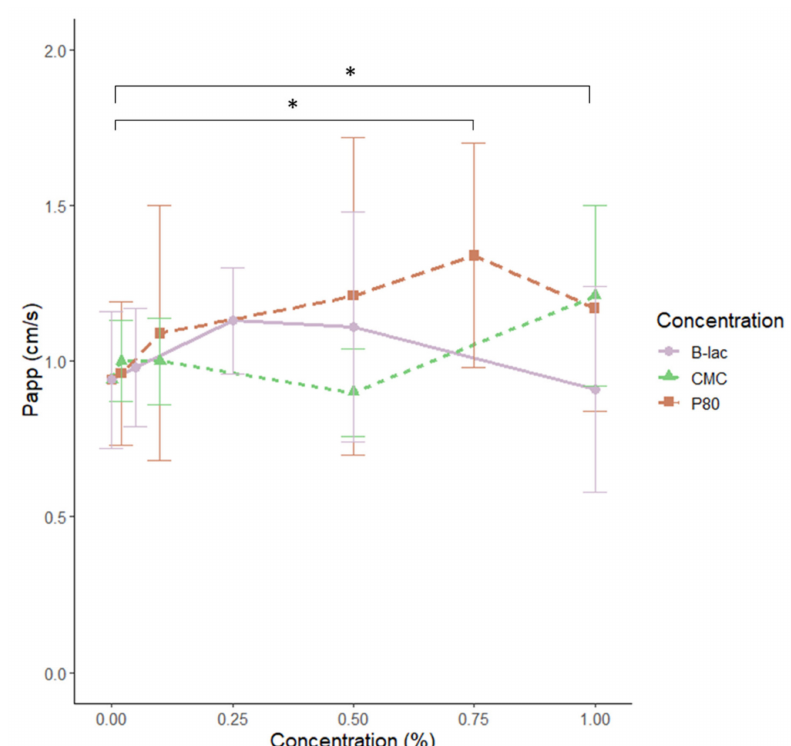
Figure 4. Apparent permeability coe ffi cient (Papp) for the marker molecule mannitol in the small intestine calculated based on the passage of mannitol through the intestine between 60–120 min. The intestinal segments were incubated with the emulsifiers P80 ( n = 13), CMC ( n = 8), and β -lactoglobulin ( n = 8) in di ff erent concentrations. The starting value represents the Papp without any added emulsifiers. The values are represented as mean values with standard deviations represented by vertical bars. The emulsifier P80 significantly increased the intestinal permeability at a concentration of 1% (* p < 0.05) and 0.75% (* p <